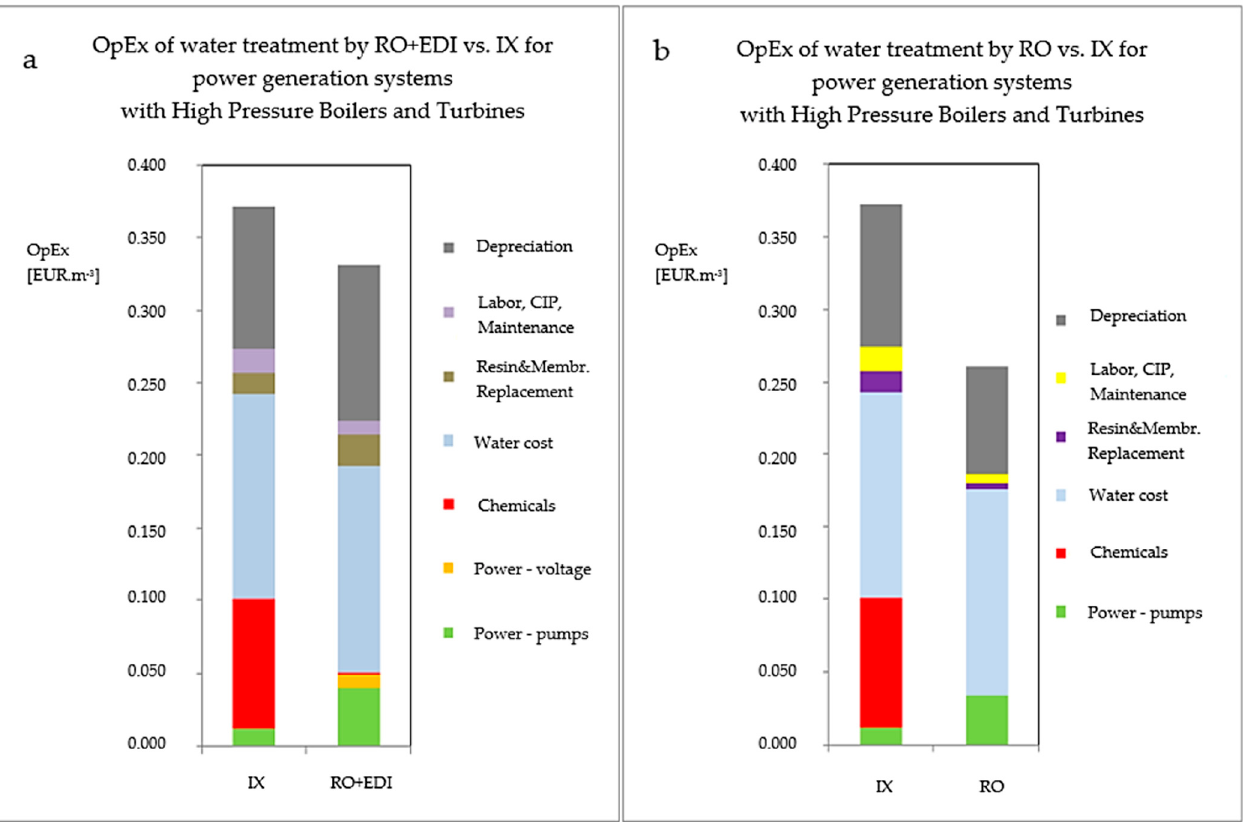
Figure 6. The total cost of 1 m 3 of water treated by membrane technology compared to ion exchange technology for 90 m 3 .h − 1 in a system with ( a ) and without ( b ) a turbine. Heating station Liberec. The water source is river Nisa. Both cases requires sufficient pretreatment to avoid utilization of UF (racks and seeves, followed by high quality spiractor or flotation for efficient clarification, and finally two stage sand filters–first with rough and second with soft sand). Table 5. Exact entries of membrane and IX technologies from Figure 6.